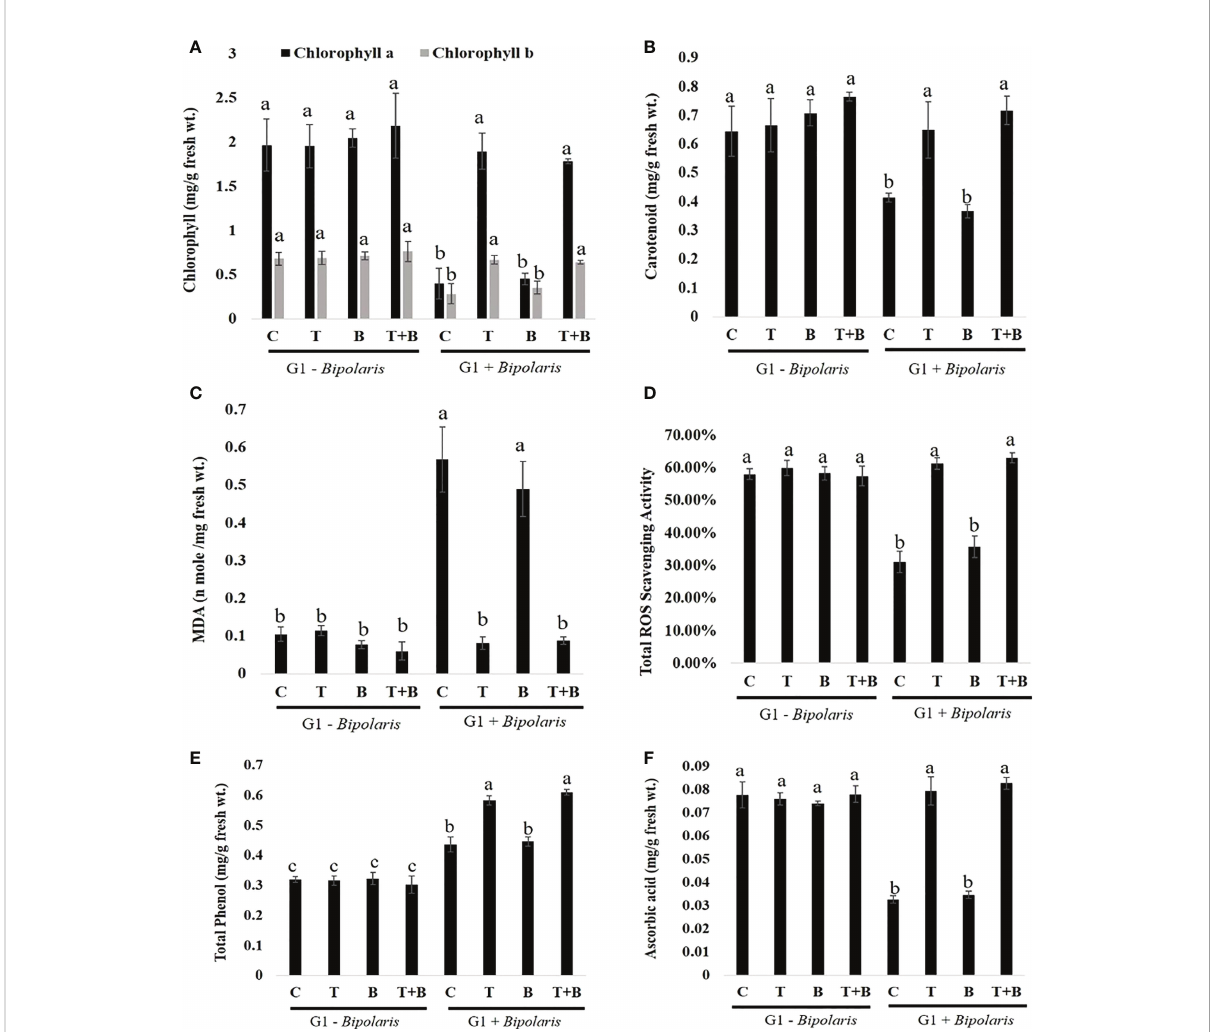
FIGURE 7 Effect of intergenerational immune priming on biochemical changes in progeny (G1) of primed and non-primed wheat (G0) after challenging with Bipolaris sorokiniana HD 3069. (A) chlorophyll a and chlorophyll b, (B) carotenoids, (C) MDA (D) ROS scavenging activity (E) Total phenol and (F) Ascorbic acid of G1 after challenging with Bipolaris sorokiniana HD 3069. C = control, T Trichoderma-primed, B = Non-primed wheat challenged with Bipolaris , T+B = Trichoderma -primed and challenged with Bipolaris . (G1 - Bipolaris ) = progeny of G0 not challenged with Bipolaris sorokiniana HD 3069, (G1 + Bipolaris ) = progeny of G0 challenged with Bipolaris sorokiniana HD 3069. Data in (A – F) are represented as mean ± SD (n=21), and different alphabets indicate statistically signi fi cant difference at P<0.05 in Tukey's test. Results are representatives of three independent biological